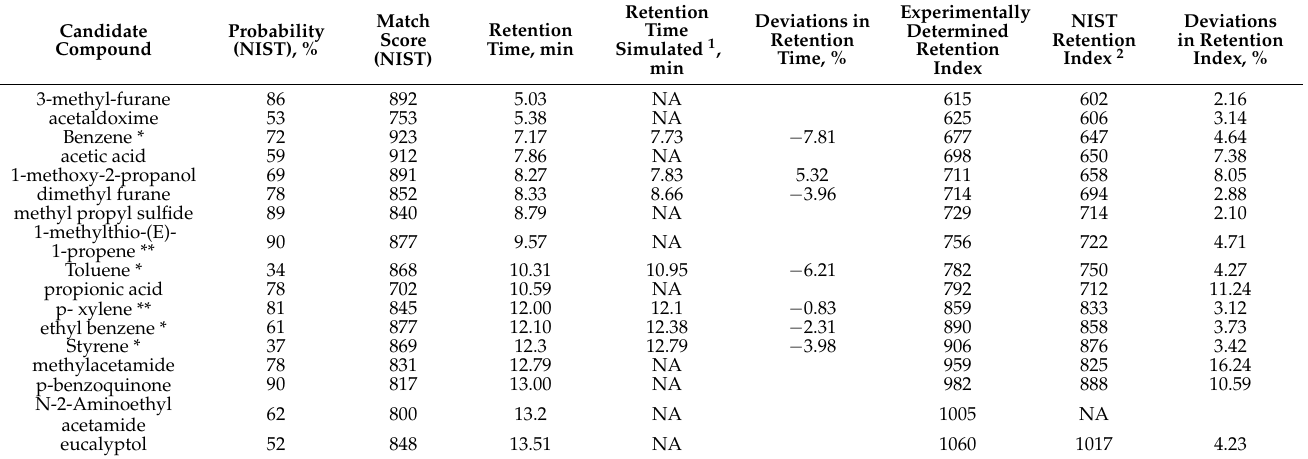
Table 1. Identification of compounds based on spectra comparison with NIST library and retention time criteria.